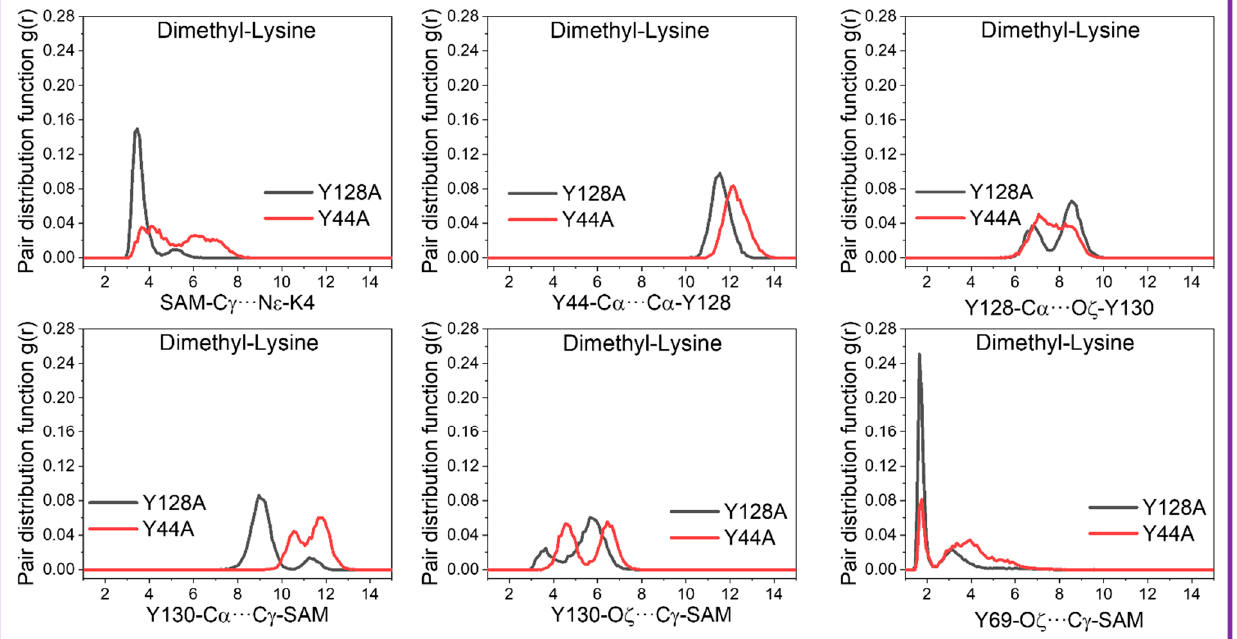
Figure 7. Plots of the pair-distribution functions for selected distances associated with the reactiva- tion mechanism sampled along 50ns of molecular dynamic simulations of Y128A and Y44A mutants with the di-methylated lysine. In the box are the interactions involving Y44A and Y128A for the systems sampled to perform the tri-methylation process.